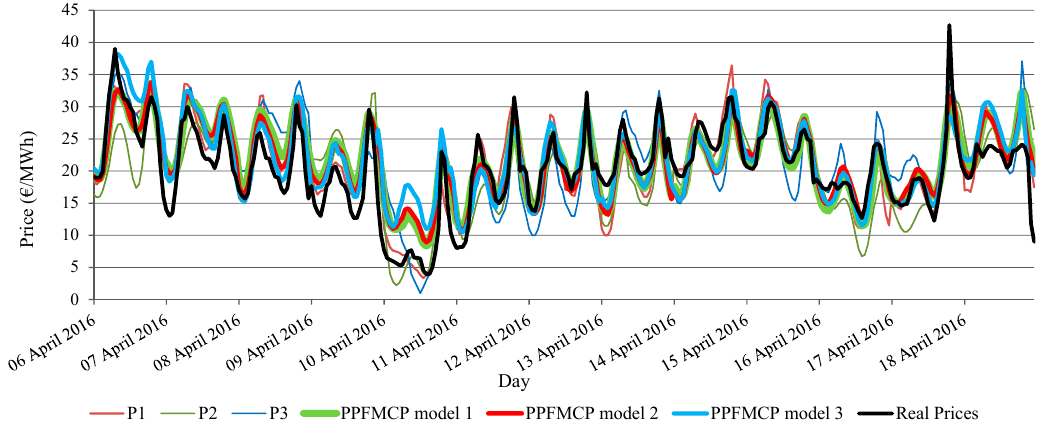
Figure 10. Point forecasts for the three best predictors P1, P2 and P3; point forecasts of PPFMCP models 1, 2 and 3; and real prices.